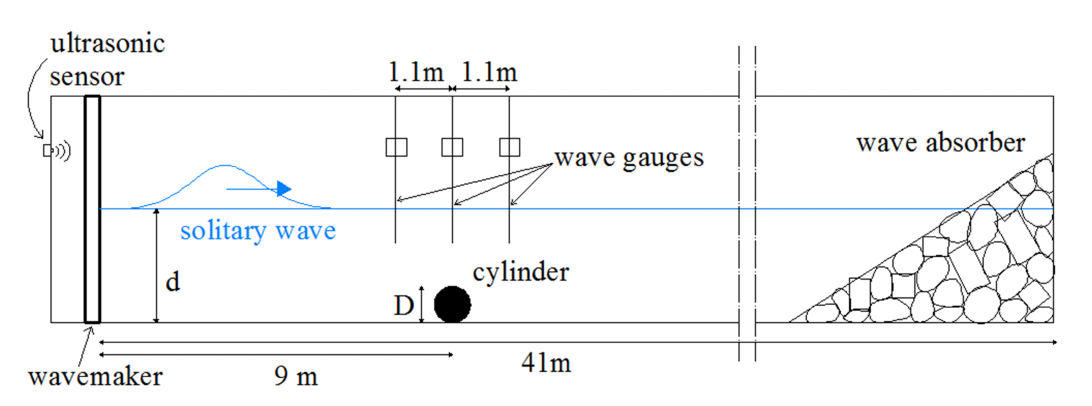
Figure 1. Sketch of the longitudinal profile of the experimental